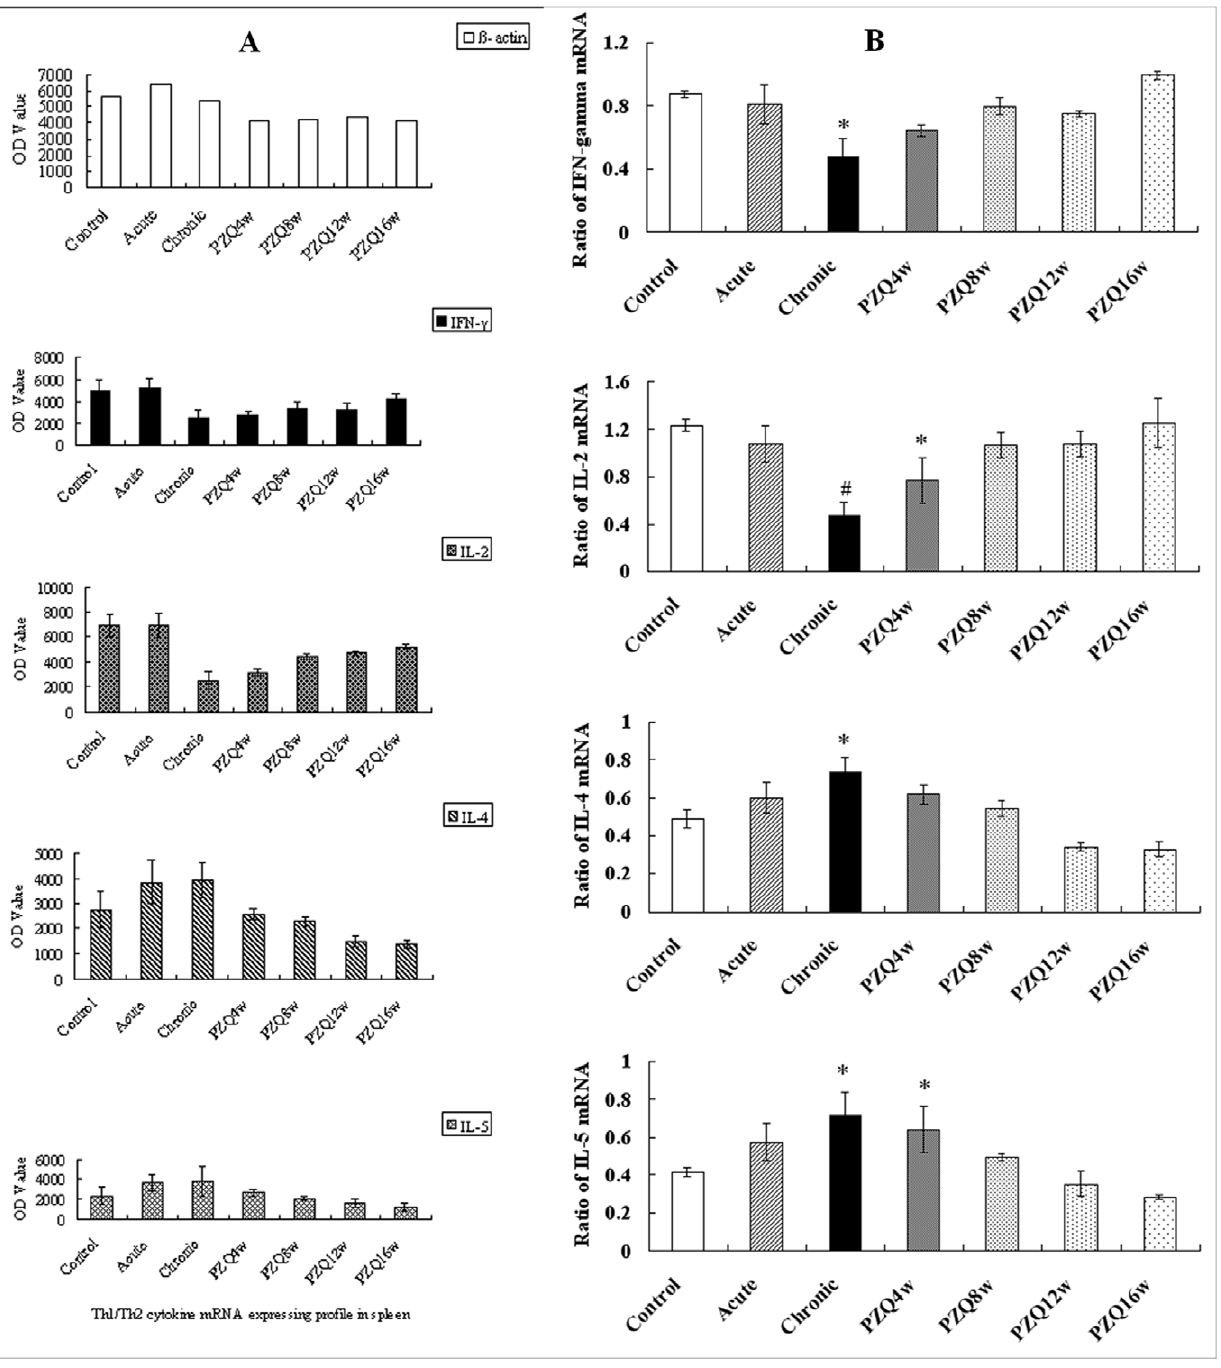
Figure 4. Levels of Th1/Th2 cytokine mRNA RT-PCR production of mice spleens. The PCR amplified fragments were analyzed on agarose gel. The optical density of each band was measured with a computer-assisted image analysis system. Relative expressions of Th1/Th2 cytokine mRNA were analyzed by the ratio of the band density of its amplified fragment over that of b -actin. A: OD values of RT-PCR products from Th1/Th2 cytokine mRNA and b -actin. B: The ratios of Th1/Th2 cytokine mRNA expression. The data in Fig. 4B does not necessarily reflect the exact ratios of each cytokine mRNA to b-actin, because PCR amplification is not exponential at high cycle numbers. *P , 0.05 versus control group, # P , 0.01 versus control group.